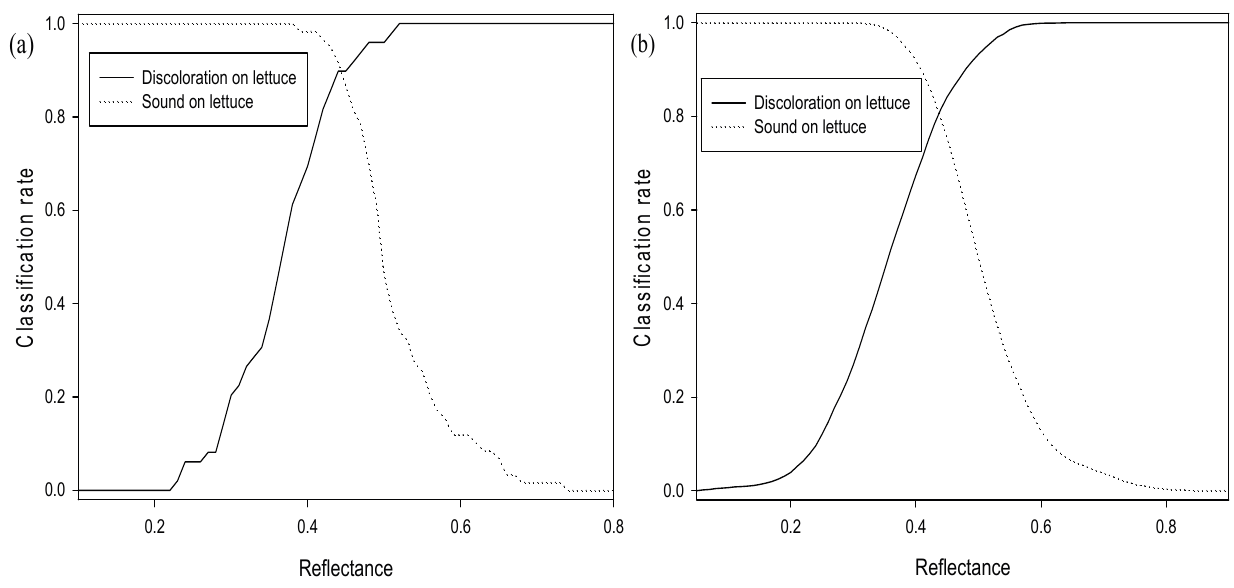
Figure 6. Classification rates for sound and discolored areas on both adaxial and abaxial surfaces using the reflectance of a 547 nm single waveband with calibration samples: ( a ) average spectrum and ( b ) pixel